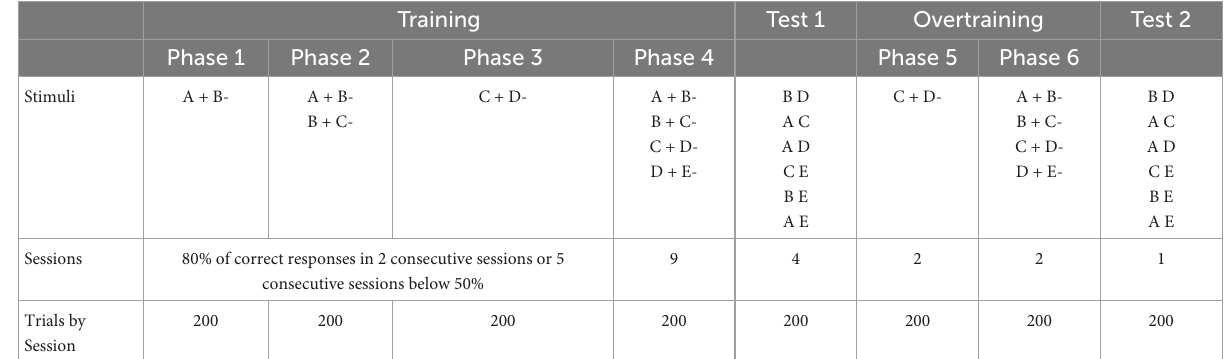
TABLE 1 Phases of the